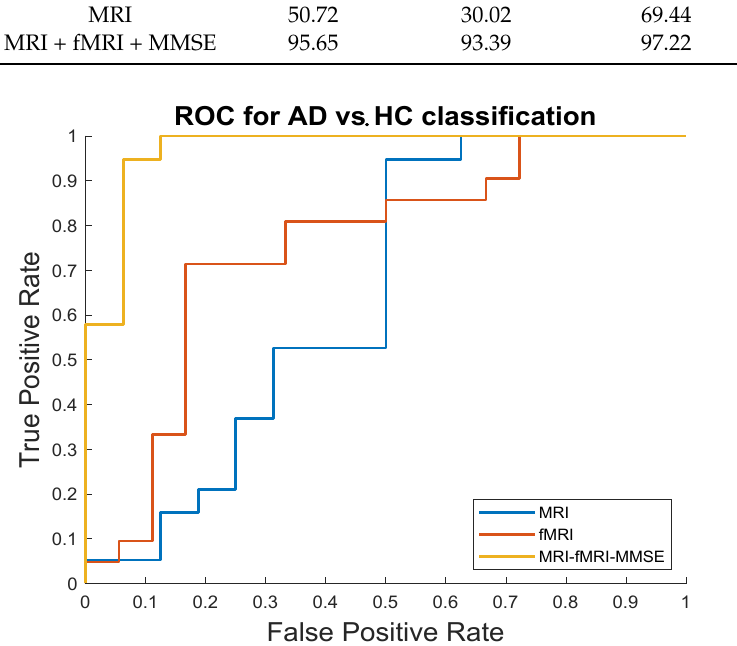
Figure 7. ROC curves of the different SVM classifiers trained using MRI, fMRI, and combined diagnostic information for recognizing AD